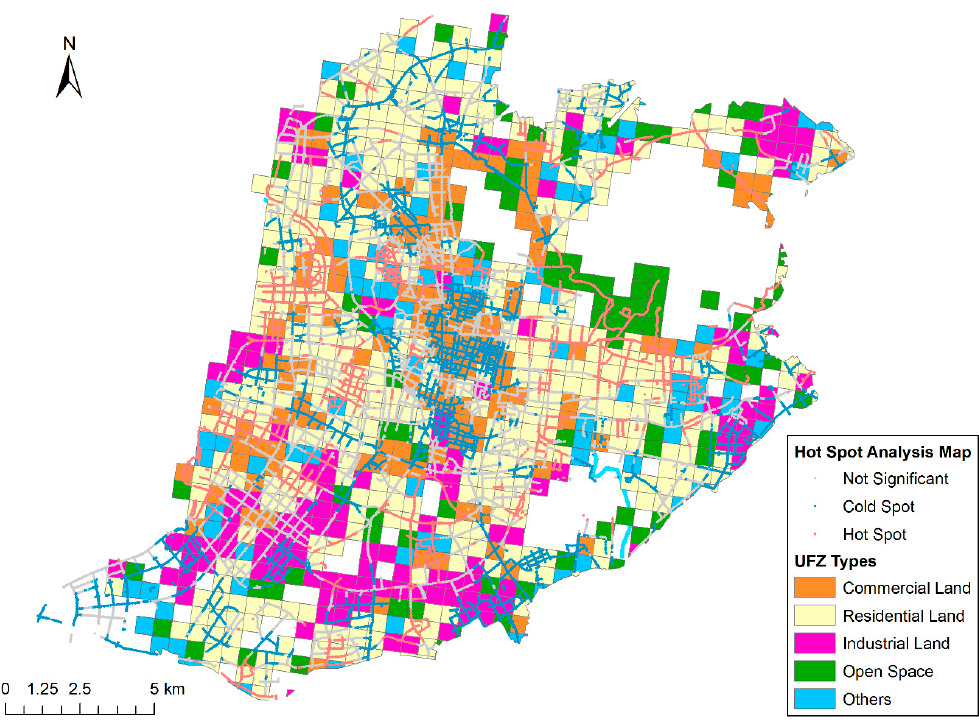
Figure 7. Hot spot analysis map overlaid on the urban functional zone (UFZ) map. Table 5. Main functions of spots.